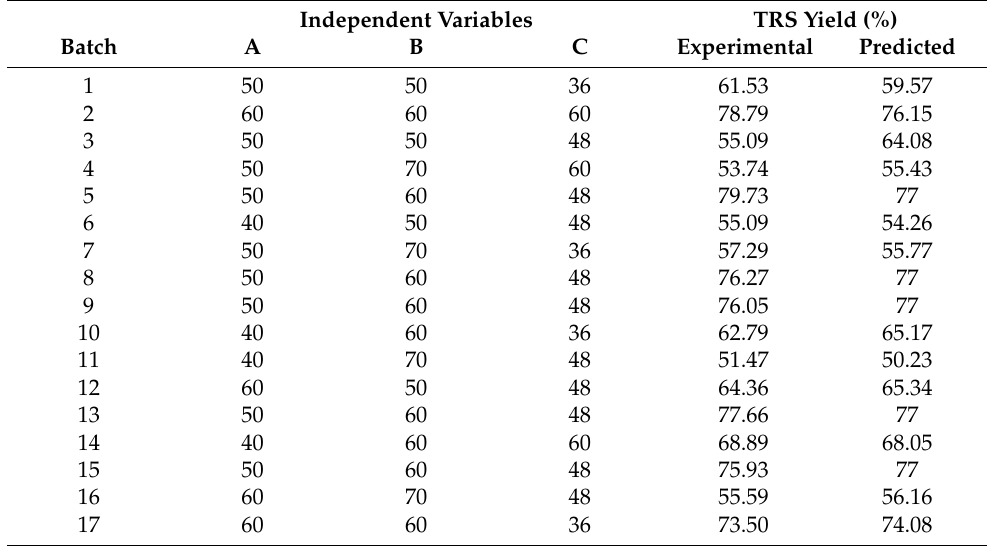
Table 4. Observed responses in the Box–Behnken design for enzymatic